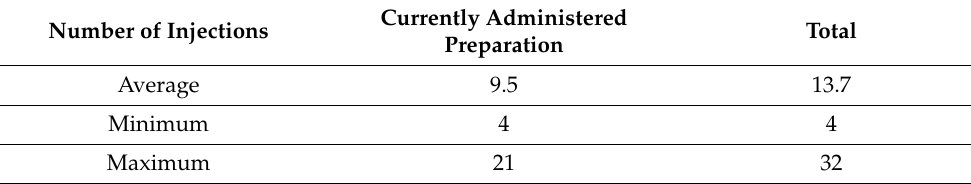
Table 1. Number of anti-VEGF injections at the time of visit “ − 2”.